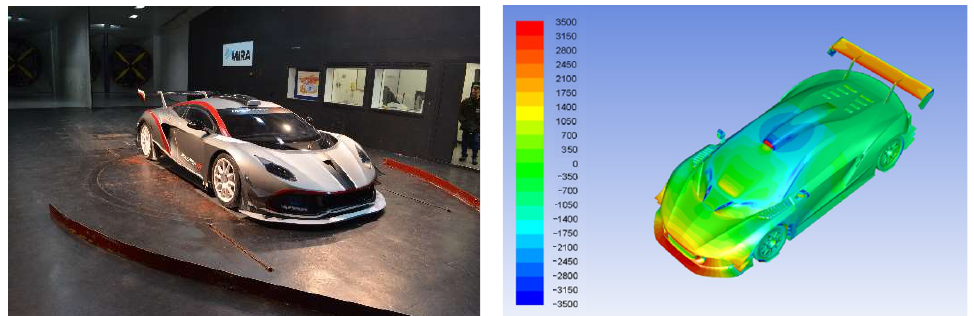
Figure 8. Prototype of GT version in MIRA wind tunnel and pressure distribution being the result of CFD simulations.